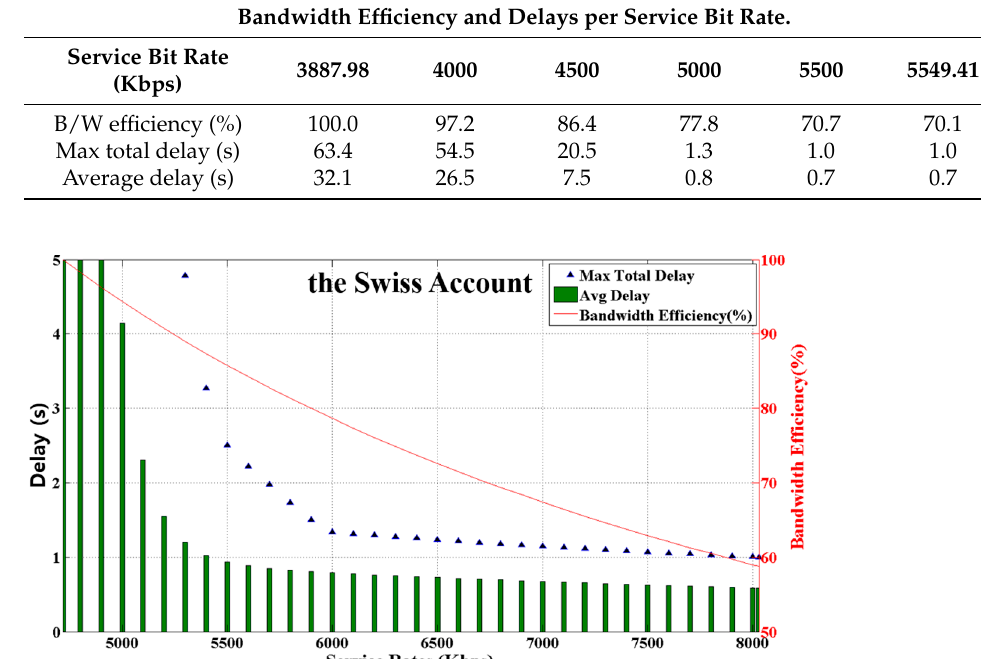
Figure 6. Simulation results of ‘The Swiss Account’.